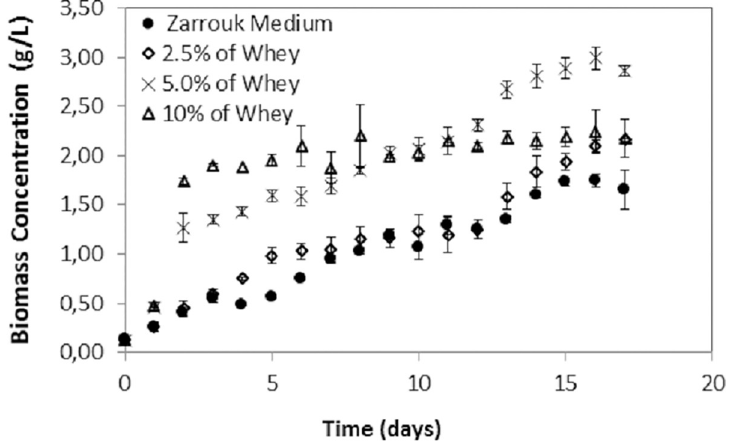
Fig 1. Growth curve of S . platensis grown on autotrophic Zarrouk medium and mixotrophic medium supplemented with buffalo mozzarella cheese whey at concentrations of 2.5%, 5.0% and 10.0%. The error bars represent the standard deviations (n = 3).